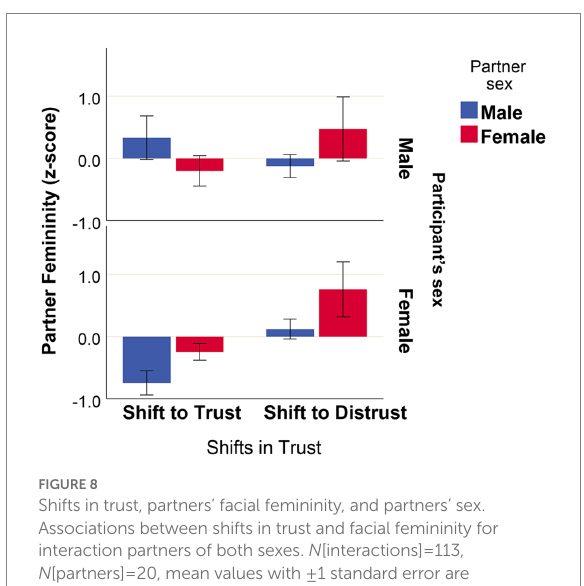
FIGURE 8 Shifts in trust, partners’ facial femininity, and partners’ sex. Associations between shifts in trust and facial femininity for interaction partners of both sexes. N [interactions] = 113, N [partners] = 20, mean values with ± 1 standard error are